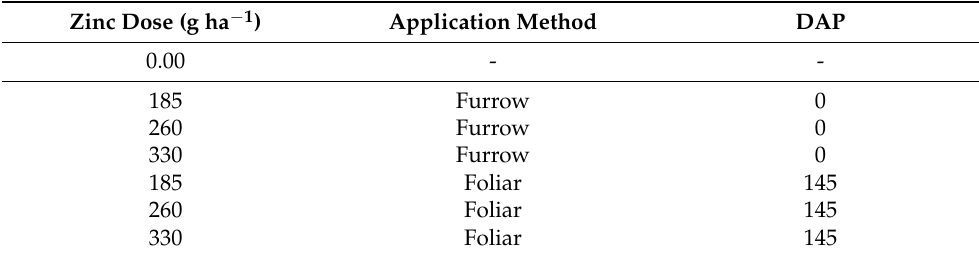
Table 2. Zinc dose treatments and application